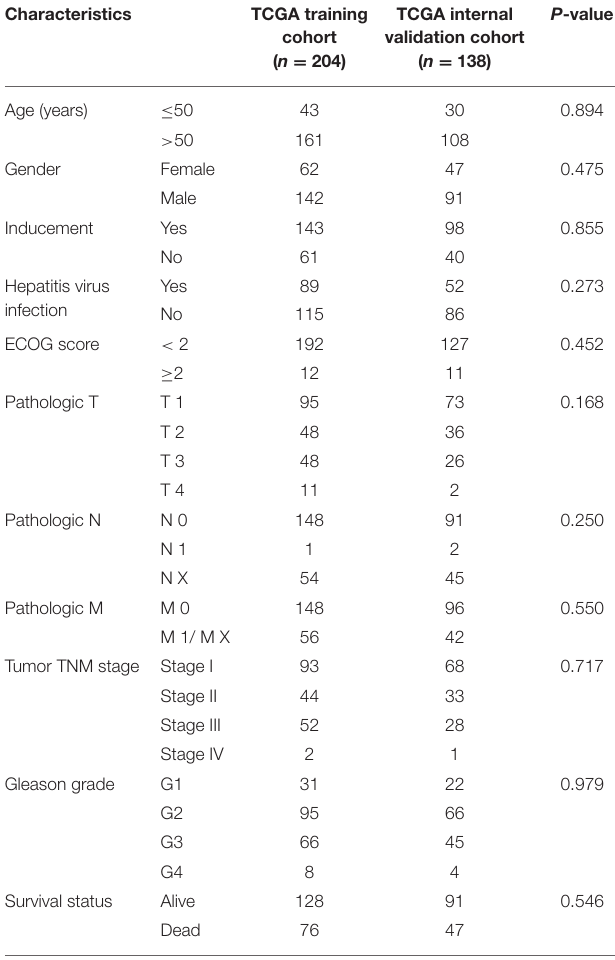
TABLE 1 | Clinicopathological characteristics between training and internal validation cohorts.